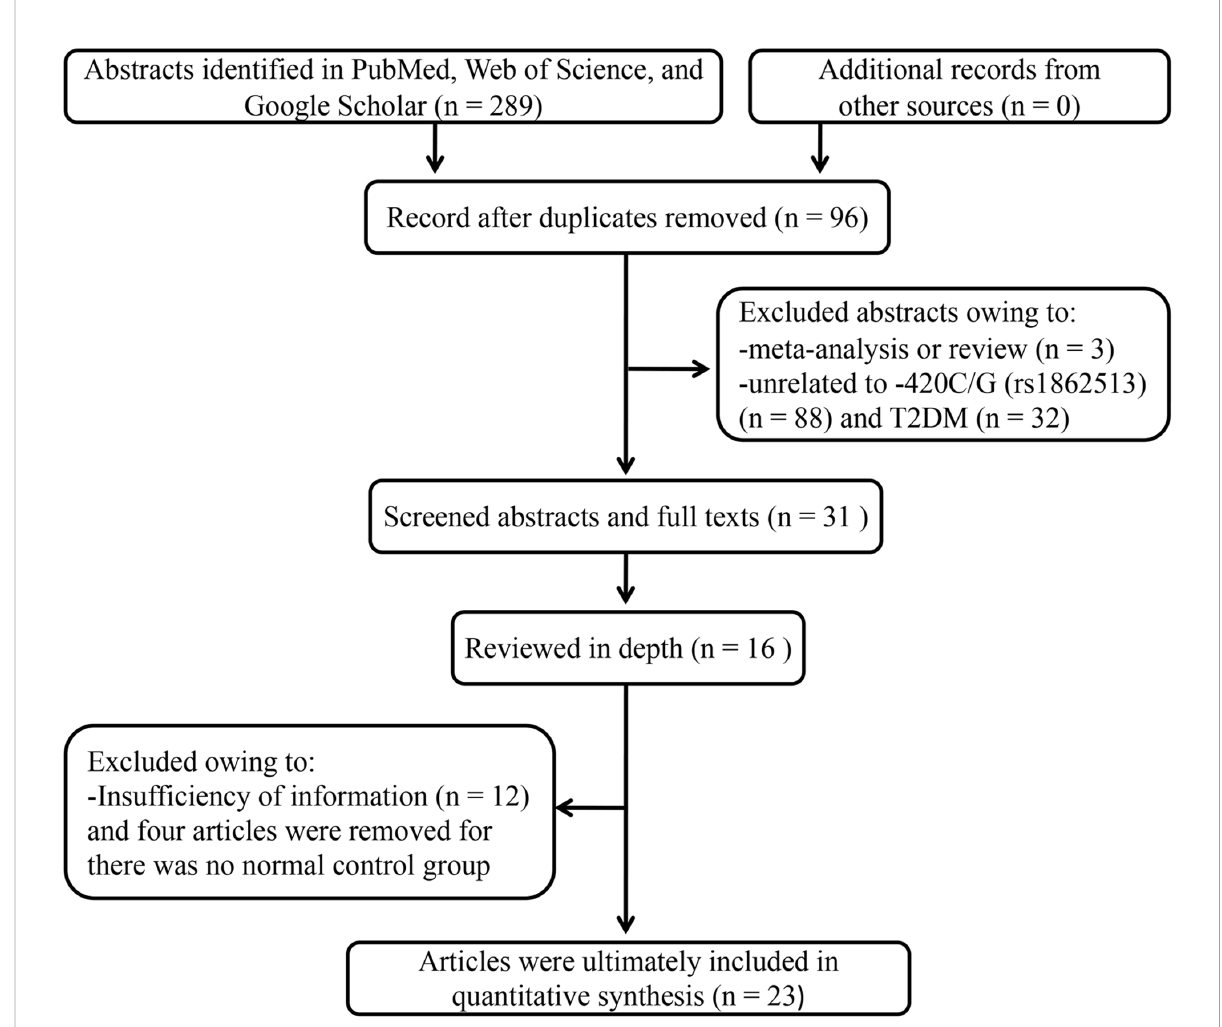
FIGURE 1 Flow diagram of the Preferred Reporting Items for Systematic Reviews and Meta-Analyses (PRISMA) study